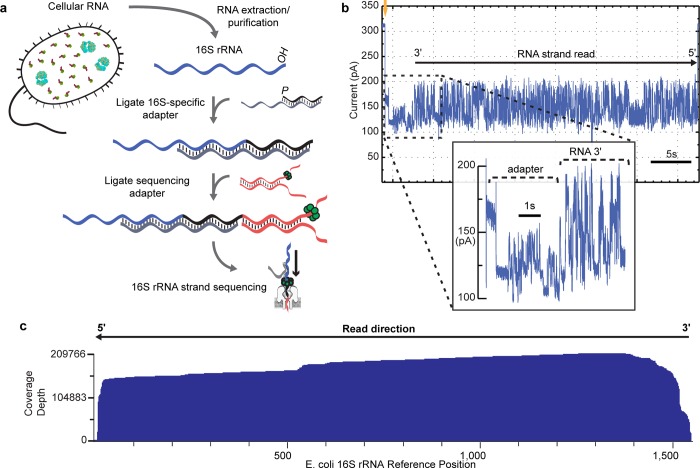
Nanopore sequencing of individual E. coli 16S ribosomal RNA strands.(a) Library preparation for MinION sequencing. Following RNA extraction, a 16S rRNA-specific adapter is hybridized and ligated to the 16S rRNA 3′ end. Next, a sequencing adapter bearing a RNA motor protein is hybridized and ligated to the 3′ overhang of the 16S rRNA adapter. The sample is then loaded into the MinION flowcell for sequencing. (b) Representative ionic current trace during translocation of a 16S rRNA strand from E. coli str. MRE600 through a nanopore. Upon capture of the 3′ end of an adapted 16S rRNA, the ionic current transitions from open channel (310 pA; gold arrow) to a series of discrete segments characteristic of the adapters (inset). This is followed by ionic current segments corresponding to base-by-base translocation of the 16S rRNA. The trace is representative of thousands of reads collected for individual 16S rRNA strands from E. coli. (c) Alignment of 200,000+ 16S rRNA reads to E. coli str MRE600 16S rRNA rrnD gene reference sequence. Reads are aligned in 5′ to 3′ orientation, after being reversed by the base-calling software. Numbering is according to canonical E. coli 16S sequence. Coverage across reference is plotted as a smoothed curve. In this experiment, 94.6% of reads that passed quality filters aligned to the reference sequence. Data presented here are from a single flow cell.